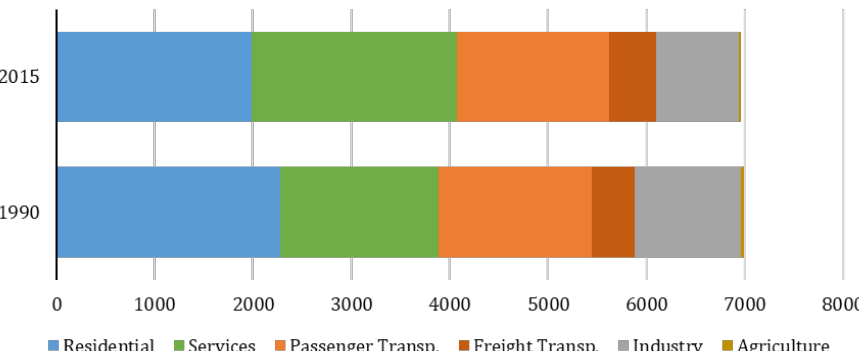
Figure 2. Change in annual final energy per sector (GWh) for the municipality of Malmö, between 1990 and 2015.